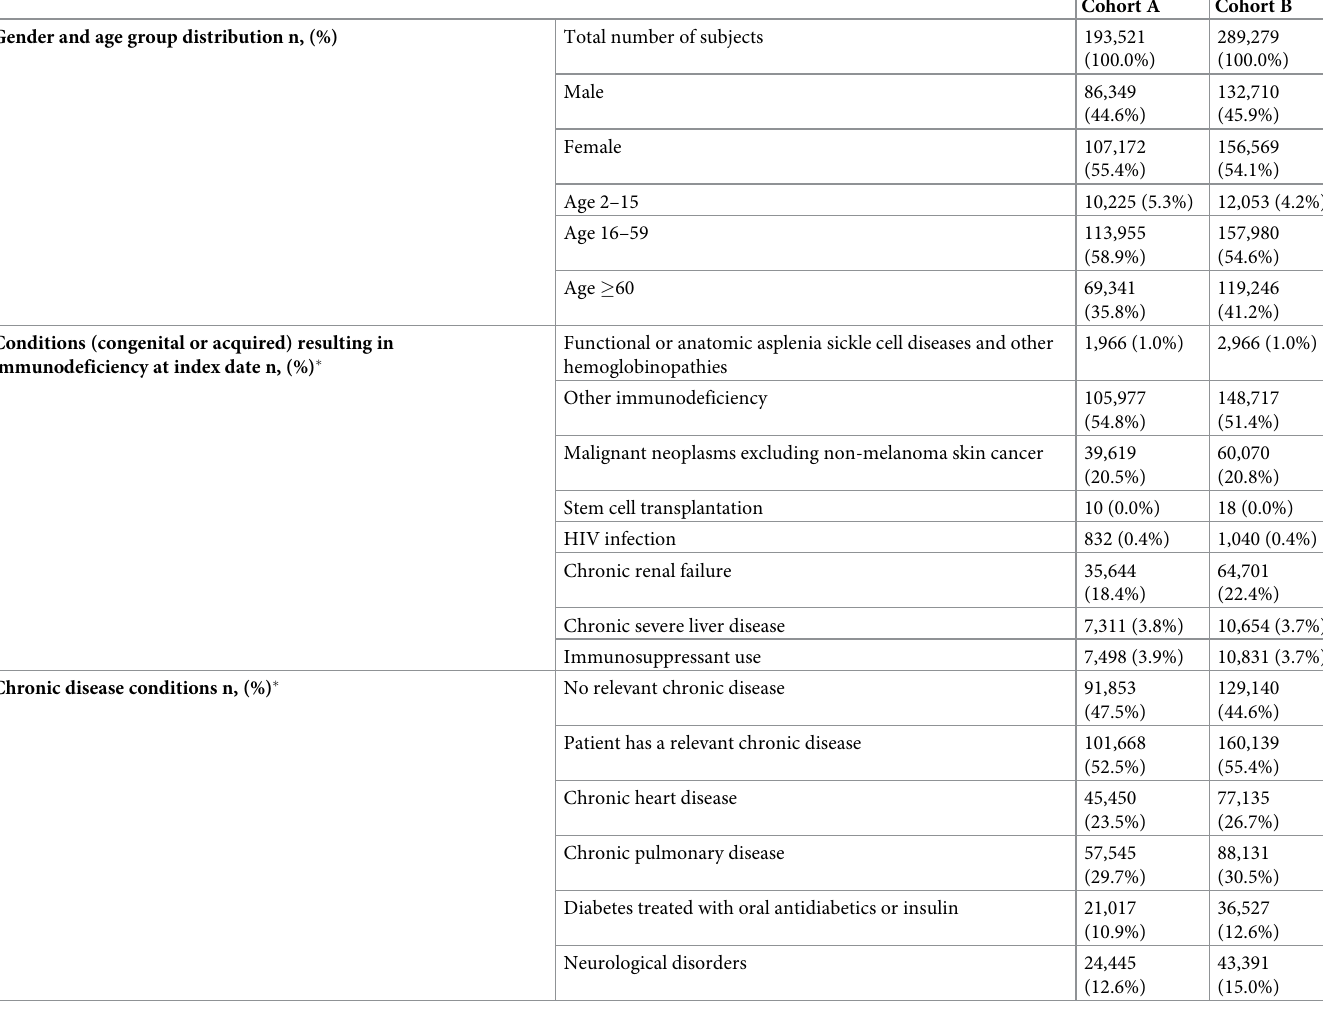
Table 2. Immunocompromised patient characteristics with a first diagnosis of a condition for which pneumococcal vaccination is recommended as per STIKO guidelines. Gender and age group distribution n,